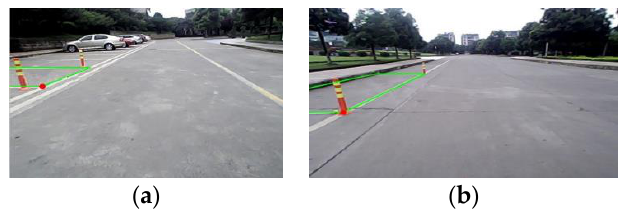
Figure 5. Matching of vertical and parallel parking spaces: ( a ) Matching on vertical parking space, ( b ) Matching on parallel parking space.